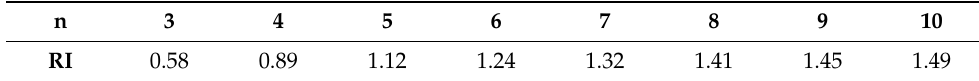
Table 4. Saaty’s ratio index (RI) for different n values [25].